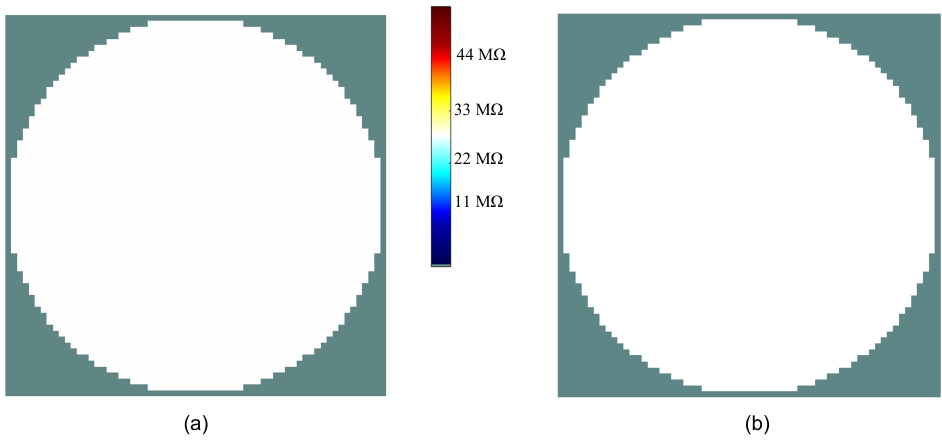
Figure 13. Comparison of image reconstruction for the calibration plane on the PC versus RPi4: ( a ) Image reconstruction using a 4 kHz signal, with no object inside the vessel and data processing on the PC, ( b ) Image reconstruction using a 4 kHz signal, with no object inside the vessel and data processing on